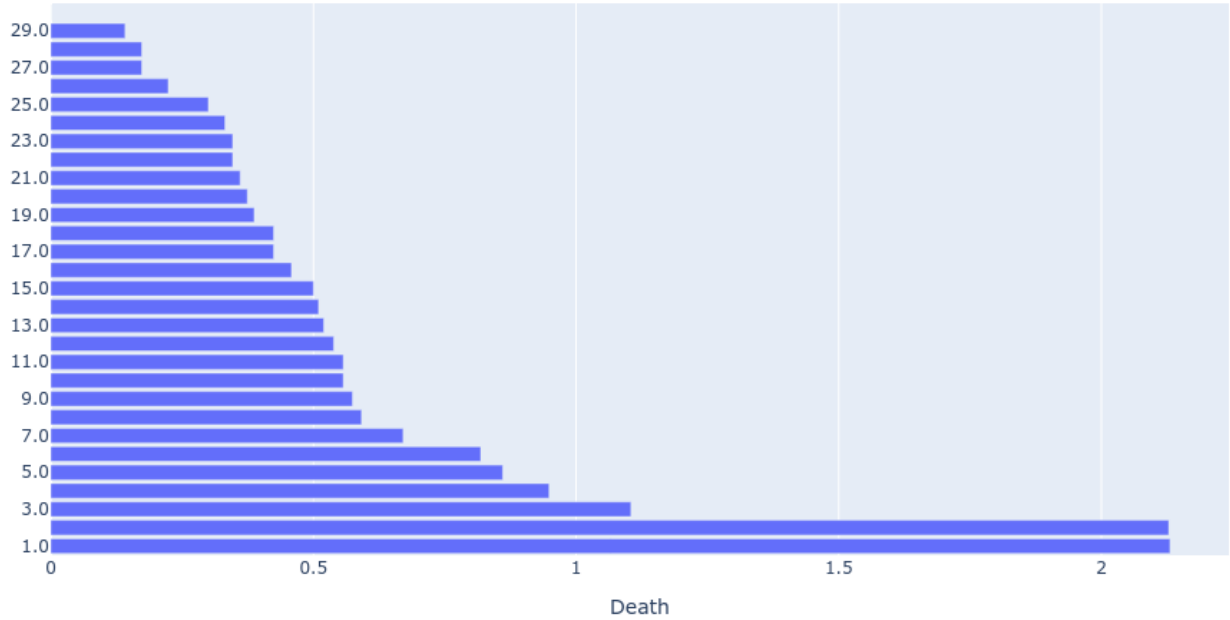
Figure 9. Bar Code result from 0-dimensional Homology analysis in Arduino Due platform. The analysis was obtained by randomly sampling 32 samples from the IRIS dataset.